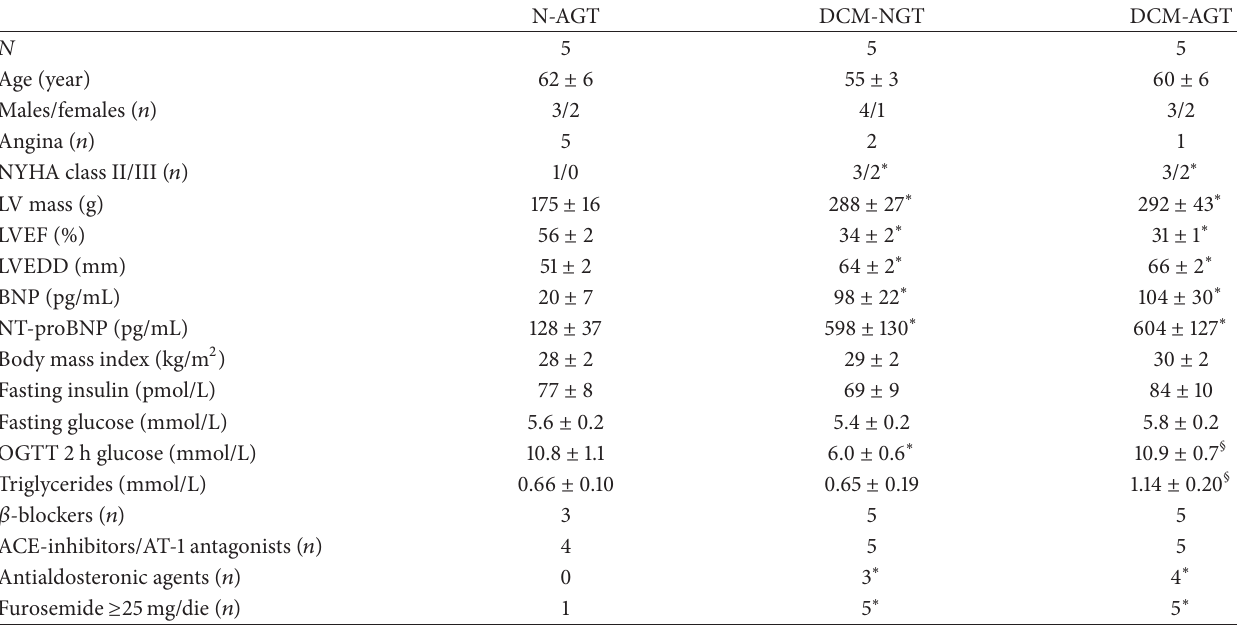
Table 1: Clinical characteristics of the study